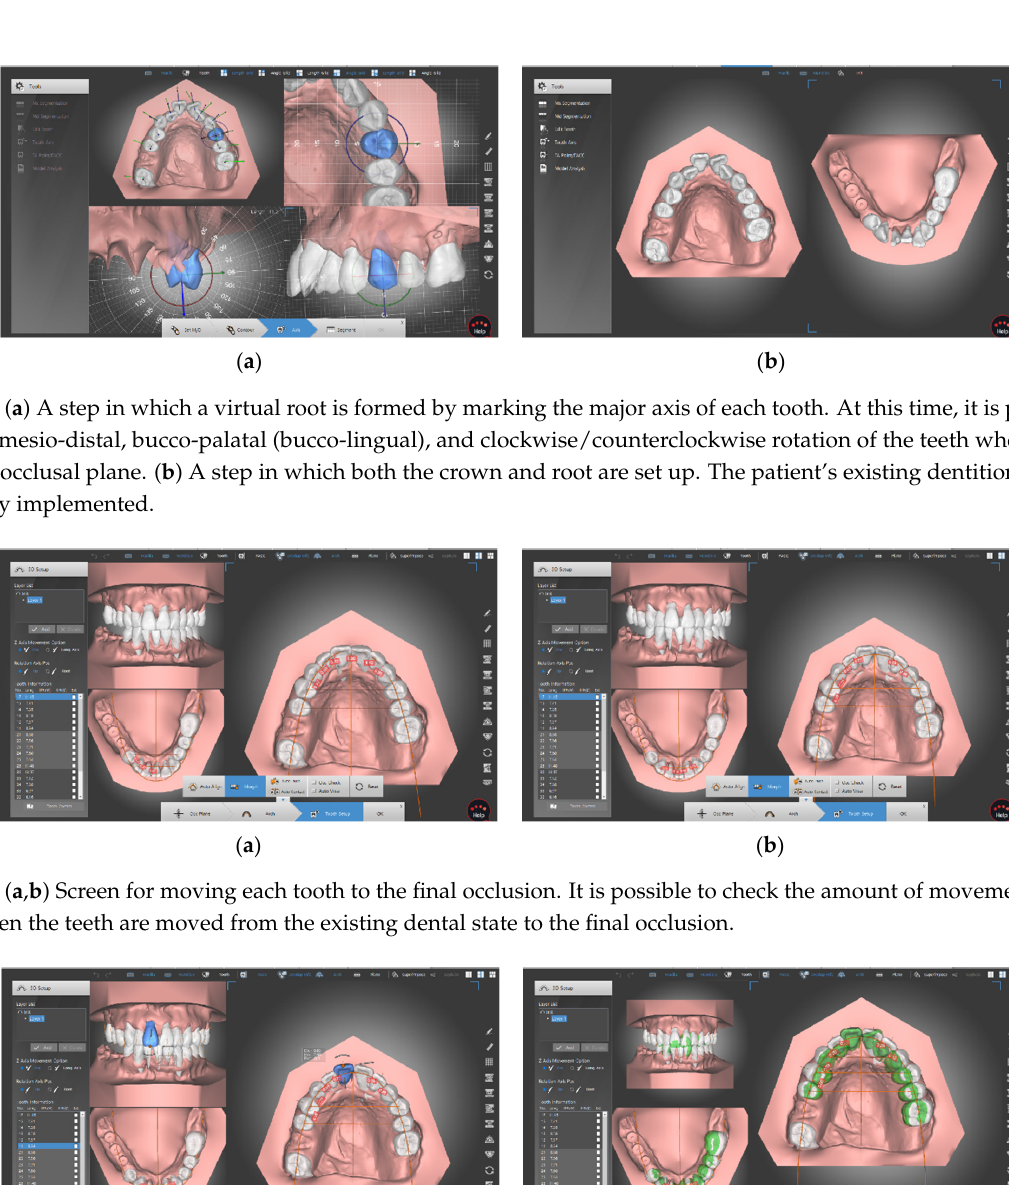
Figure 5. ( a ) In order to more accurately realize the crown of each tooth, the screen is curved by placing additional dots between the markings of each tooth performed in Figure 4b. The degree of curvature is also freely adjustable. The gingival margin and the boundaries between the teeth are precisely marked. ( b ) The screen of ( a ) viewed from the front.